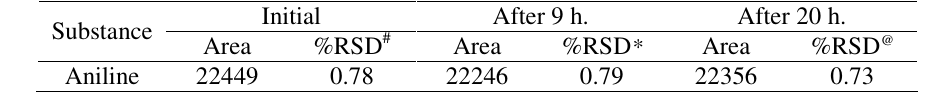
Table 7. Standard solution stability results